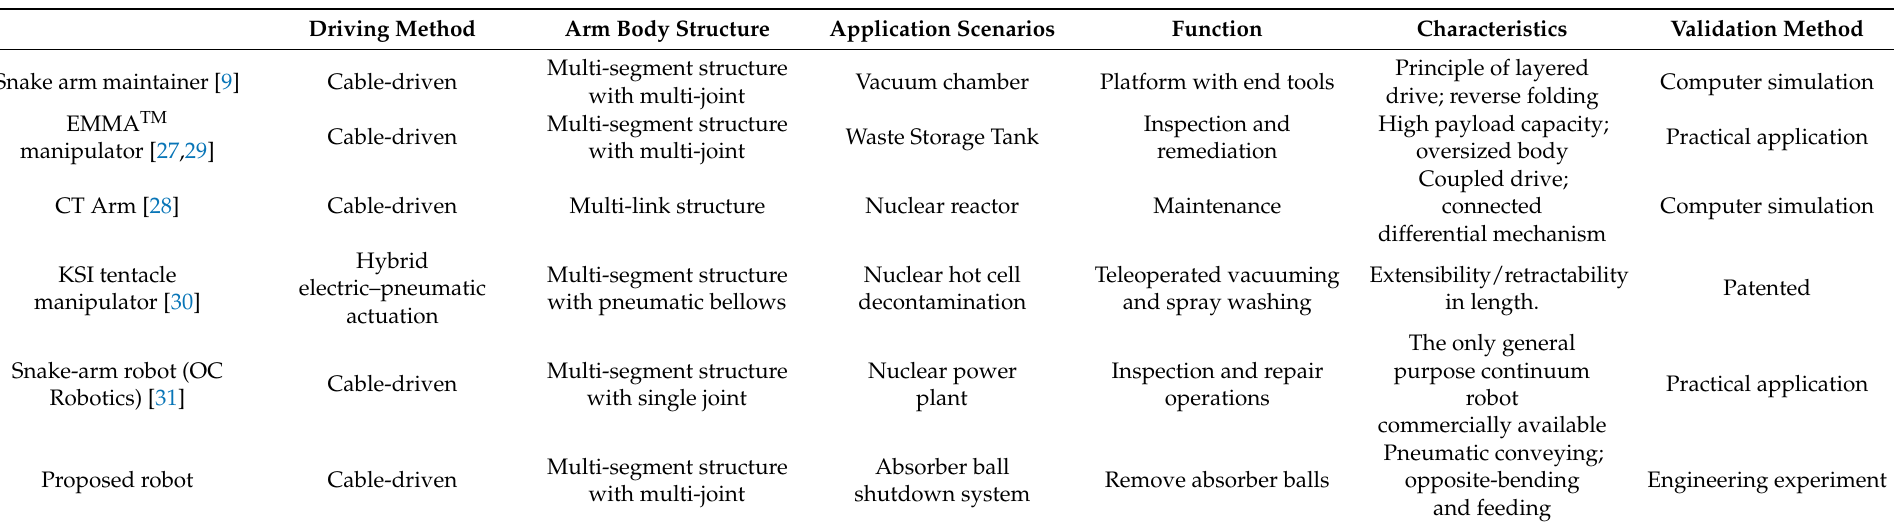
Table A1. Comparison of relevant characteristics of different continuum robots for nuclear